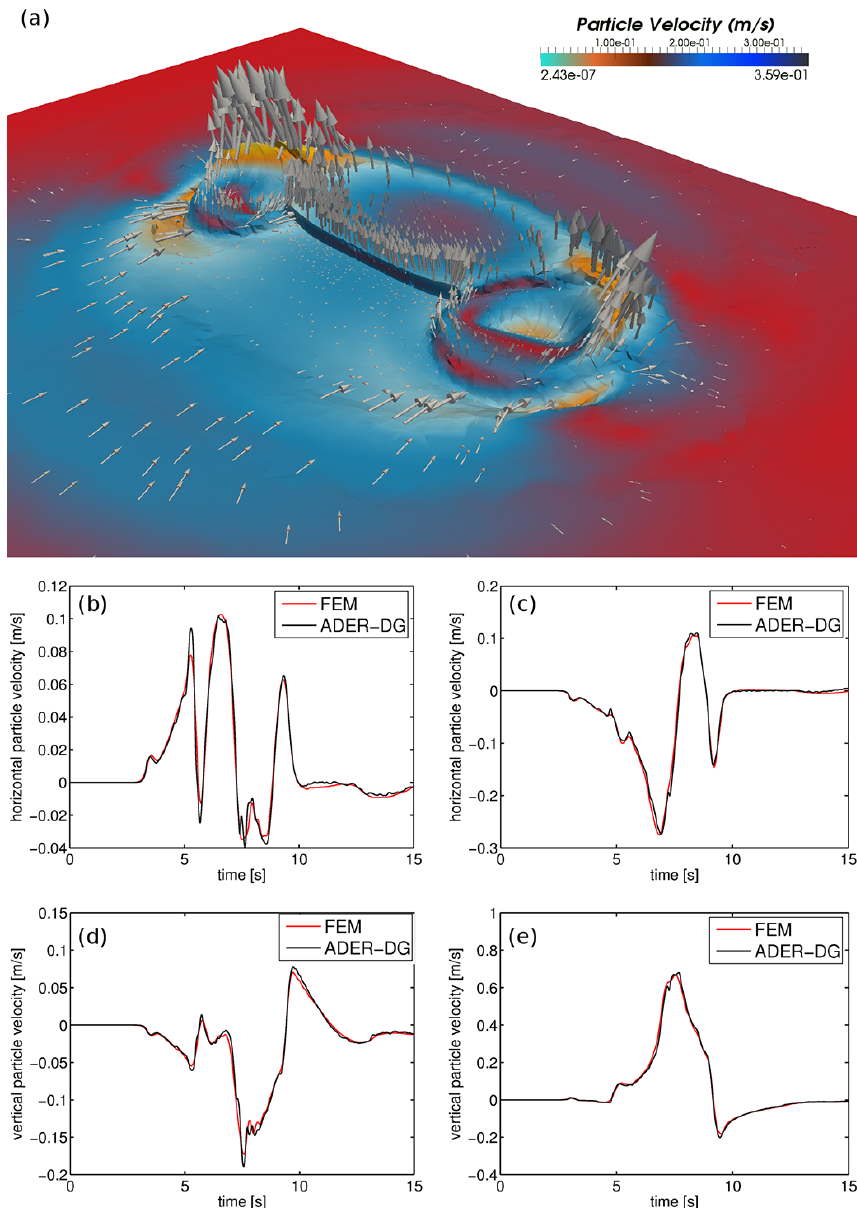
Fig. 3. (a) Asymmetric ground motion in the surrounding of the dipping fault at t ≈ 8s in TPV10. The color scale indicates the magnitude of absolute particle velocity at the surface, arrows and surface morphology reflect its direction. (b) and (c) are horizontal ground velocity time series at seismic stations located 3km away from the fault trace and 12km along-strike on the foot wall and hanging wall, respectively. (d) and (e) are the vertical ground velocities at the same stations. The ADER-DG solution is shown in black, the FEM comparison solution in